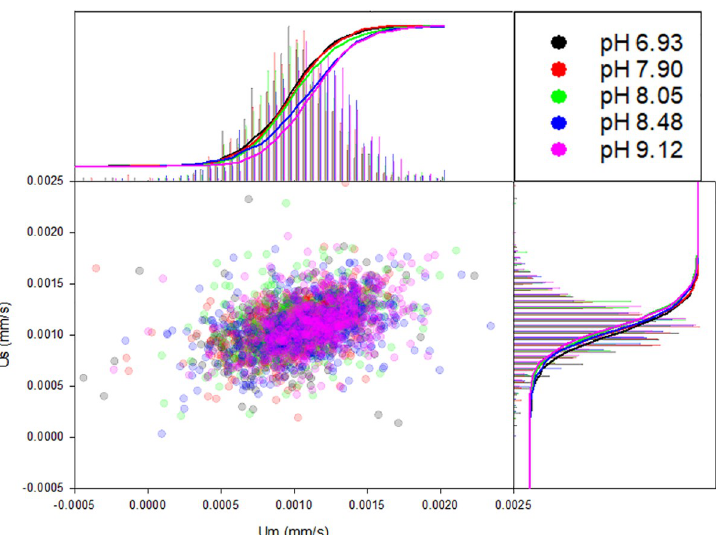
Fig 7. CTV data with AS-3 buffer pH gradient. A sample from donor F1 was measured using AS-3 as the RBC storage solution at five different pH values. Serial additions of NaOH increase pH and decrease viscosity. Converting to pgHb/cell reveals an average of 26.7 ( ± 1.1 SD) pgHb/cell between the buffers.